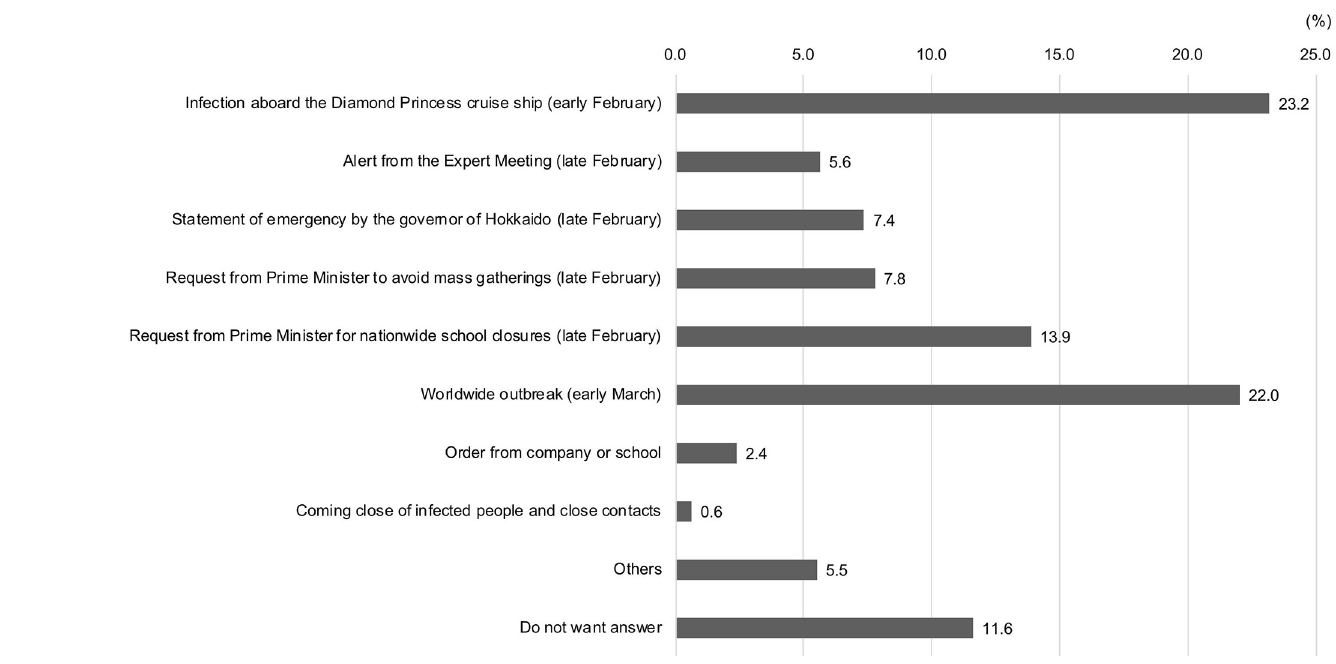
Fig 1. “What was the most important event influencing these